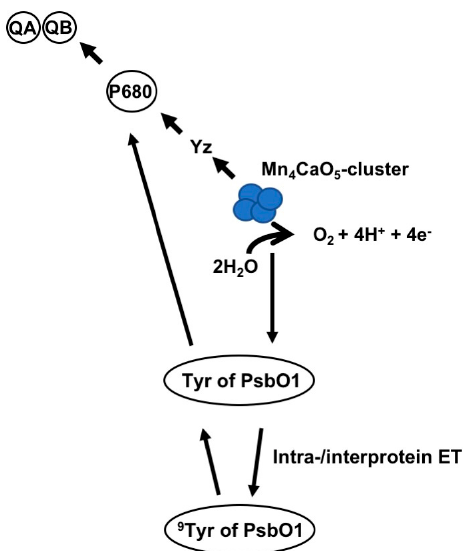
Figure 8. A model to hypothesize a novel role of the ninth tyrosine residue of PsbO1 ( 9 Tyr) in photosynthetic electron transport in PSII. Hypothetical long range inter- and intra-molecular electron transfer from manganese cluster to P680 + via 9 Tyr of PsbO1 supported the 9 Tyr as a novel electronic element, like Y z , in the PSII electron transport.